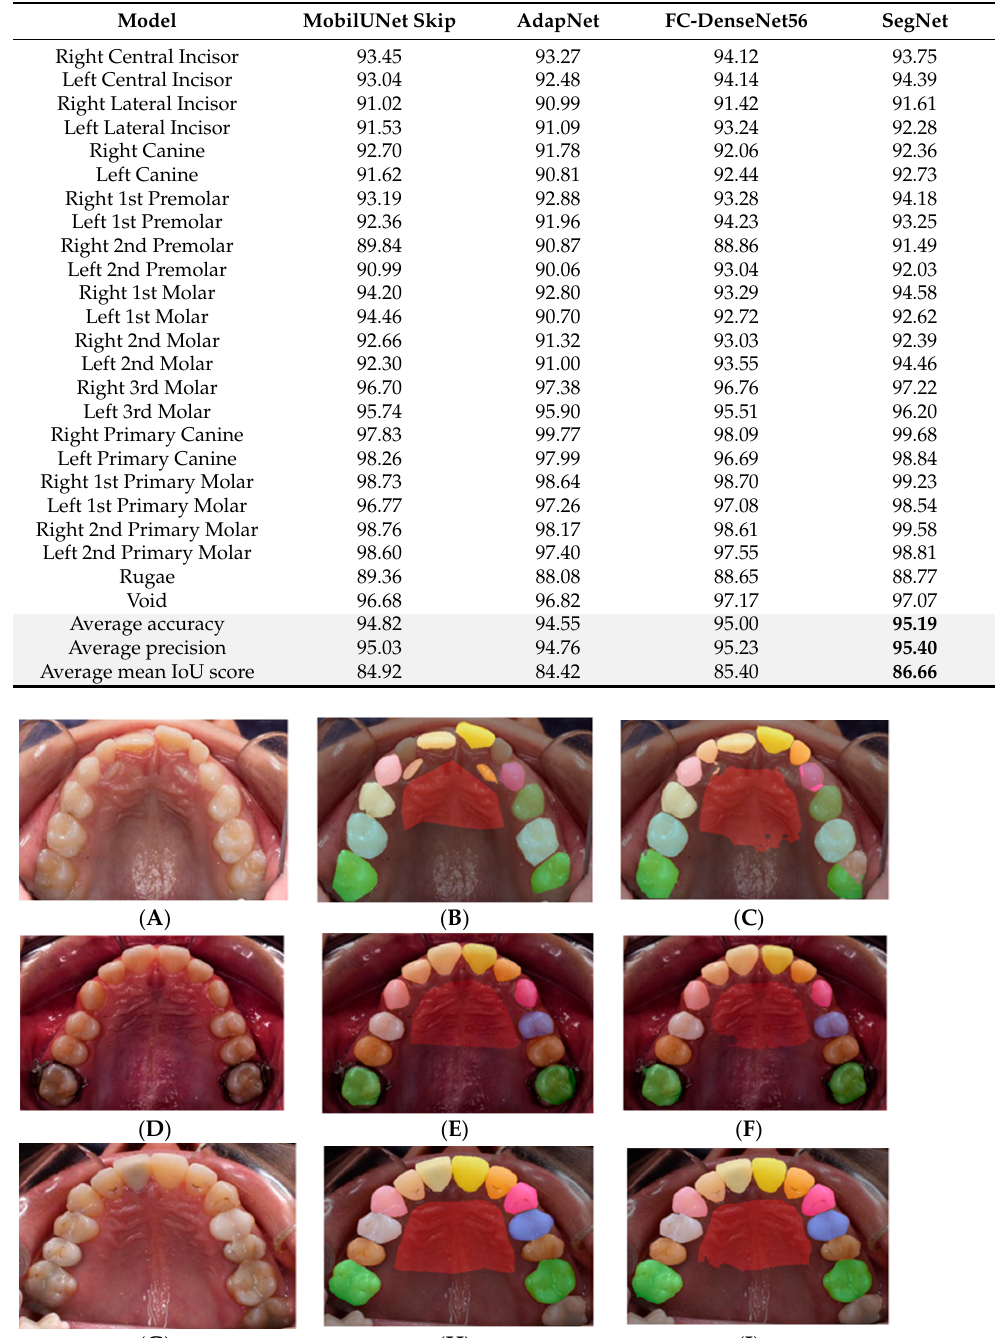
Table 4. Model architecture comparison on specific tooth labels with rotation for all architecture candidates.